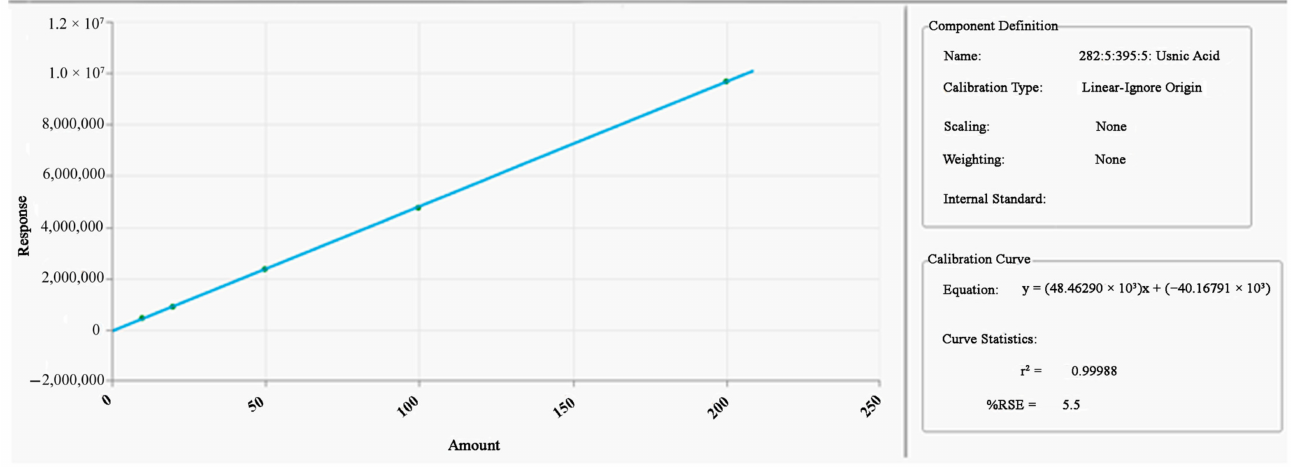
Figure 6. The calibration curve of usnic